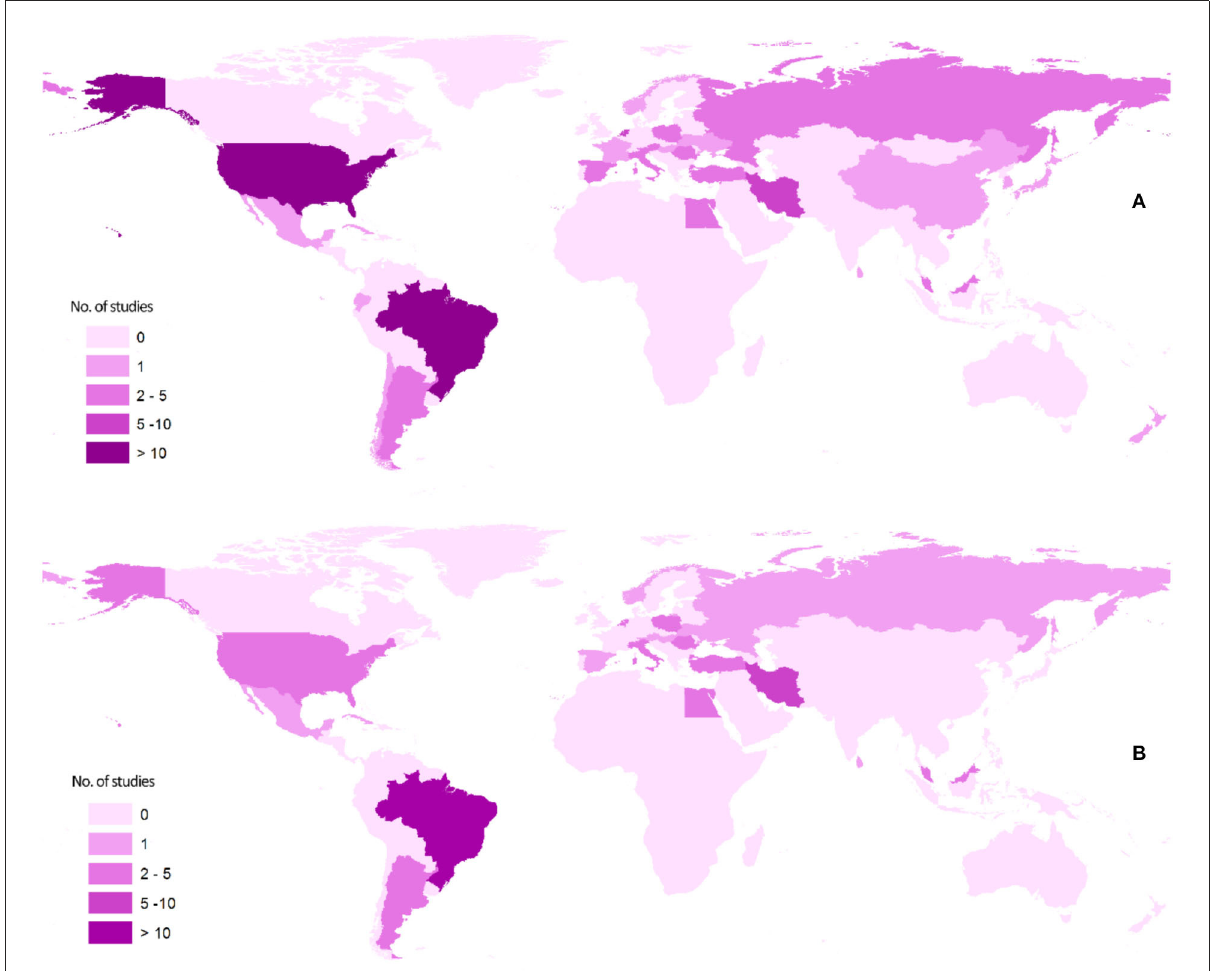
FIGURE2 Maps showing the geographical distribution of the literature published on the association of asthma and Toxocara serology: (A) articles of all types and (B) analytical articles, that is, cross-sectional, case-control, and